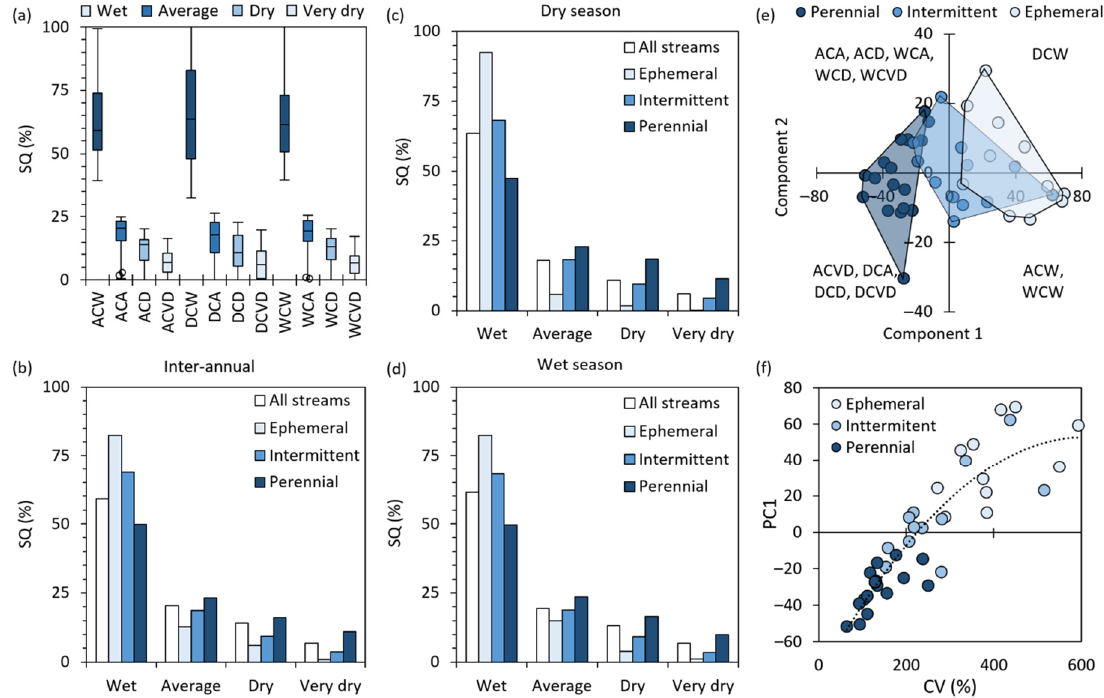
Figure 4. Exploratory data of the standardized relative discharge contribution (SQ%) and stream types relationship with the principal components and coefficient of variation index (CV%). ( a ) Central and full range distribution of inter-annual variability (A) per the hydrological condition (C): wet (W), average (A), dry (D), and very dry (VD) (nomenclature: ACW, ACA, ACD, and ACVD), dry season (DCW, DCA, DCD, DCVD), and wet season (WCW, WCA, WCD, WCVD) with outliers displayed in circles. Medians of hydrological condition per stream type of ( b ) inter-annual, ( c ) dry season, and ( d ) wet season variability. ( e ) Biplot of principal components 1 and 2 eigenvectors; and ( f ) polynomic regression between the coefficient of variation and the principal component.